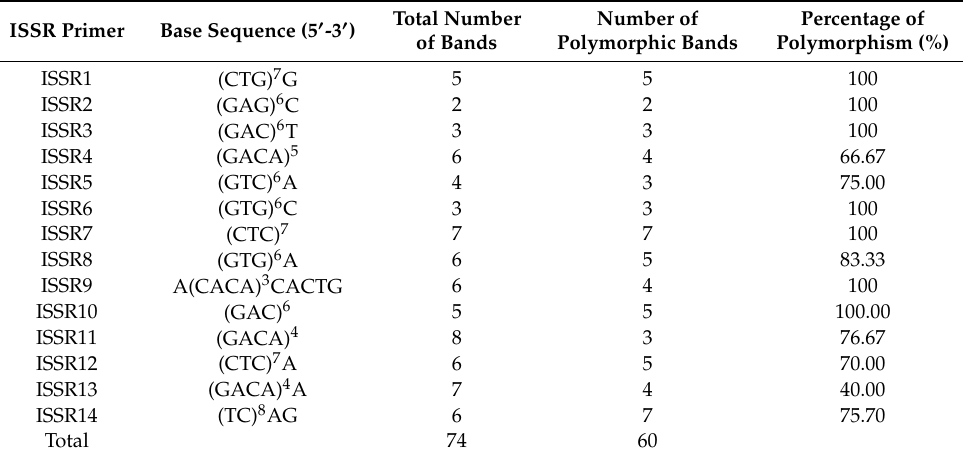
Table 9. Inter simple sequence repeat (ISSR) marker used for genetic diversity of S. italica . ISSR Primer